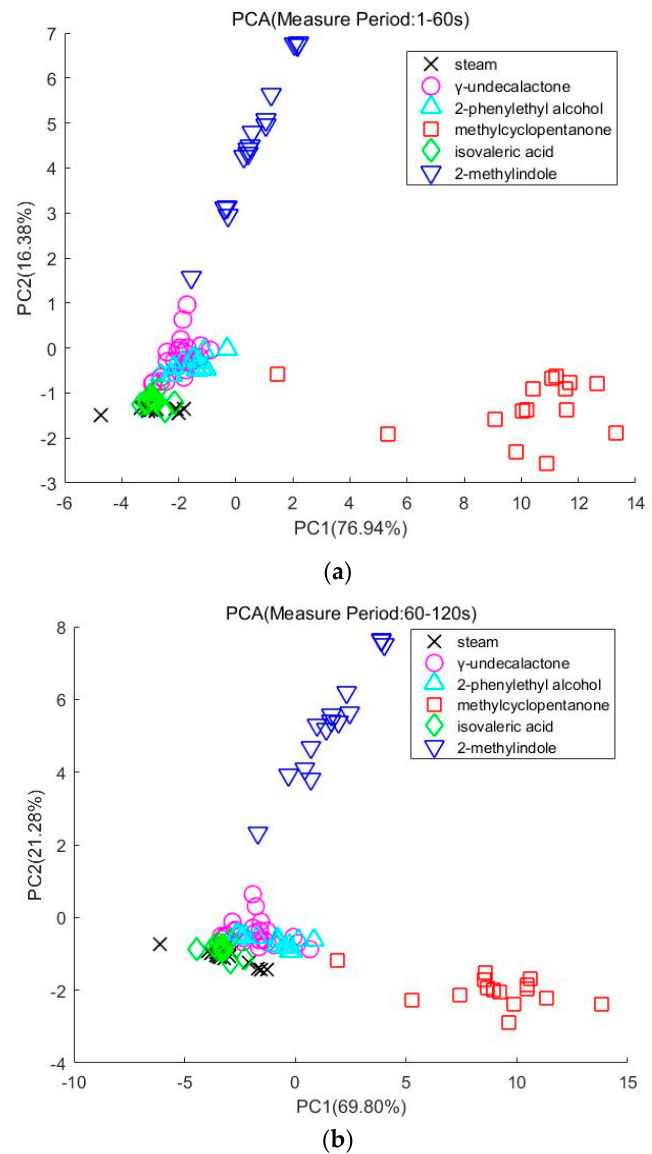
Figure 6. (a) PCA(Measure Period:1-60s). (b) PCA(Measure Period:60-120s). Figure 6. ( a ) PCA (Measure Period: 1–60 s). ( b ) PCA (Measure Period: 60–120